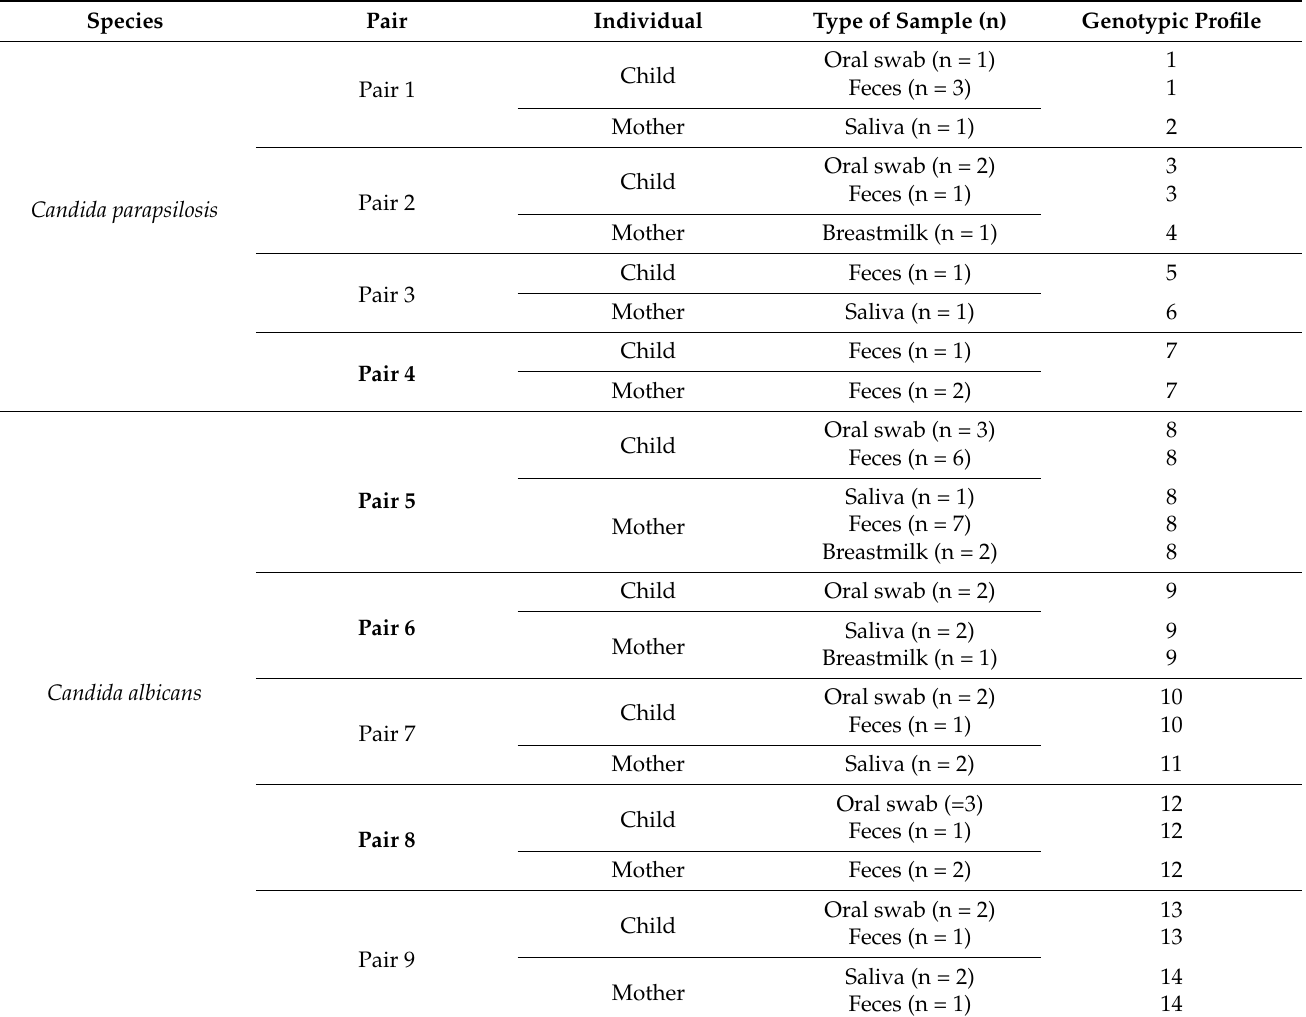
Table 3. Genotypic profiles and origin of isolates collected on mother and child